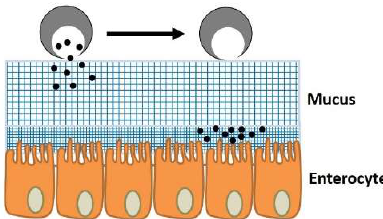
Figure 1. The structure and function of the mucus. The schematic shows the gastric mucus layer, the attachment of particles to the outer and inner mucus, and the drug delivery vehicle on the outer mucus.